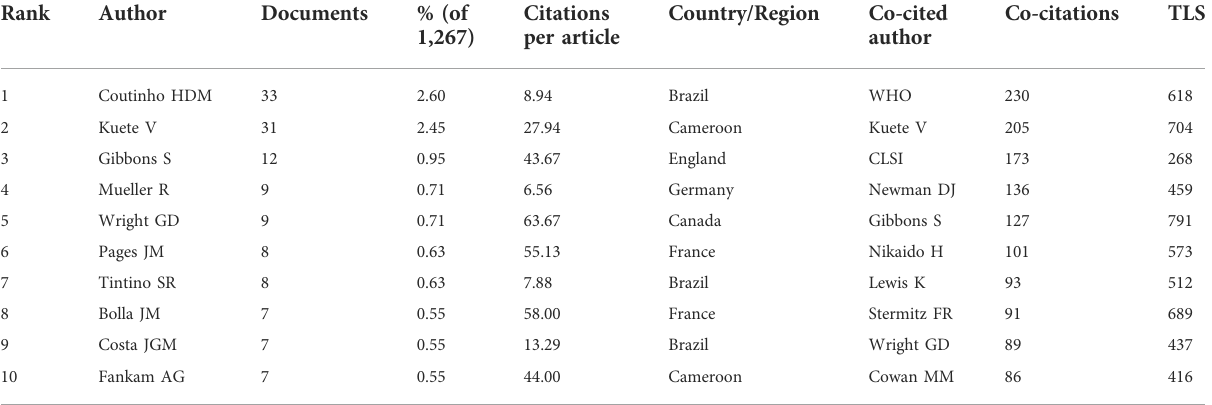
TABLE 2 The top 10 authors and co-cited authors related to resistance of natural products to MDR bacteria.